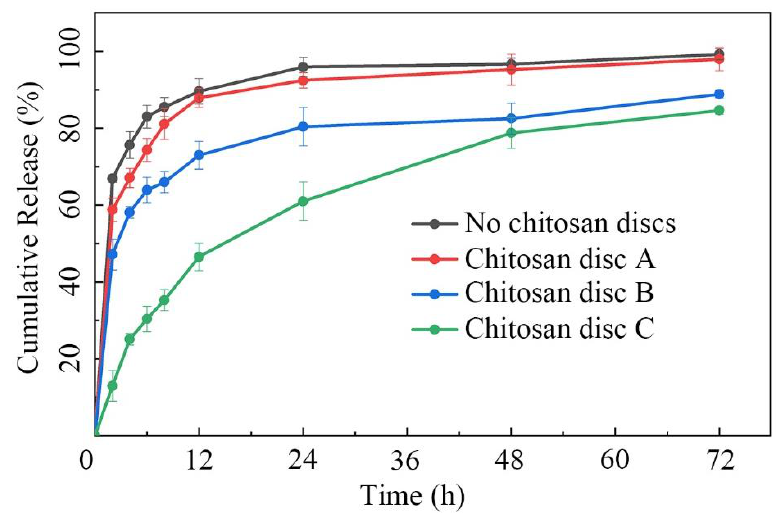
Figure 4. Cumulative release plot of minocycline in 72 h. The minocycline burst-released within 12 h in the microfluidic/chitosan device with no discs/disc A/disc B. The minocycline demonstrated sustained release over 48 h in the microfluidic/chitosan device with disc C. Error bars represent the standard deviation of the mean.